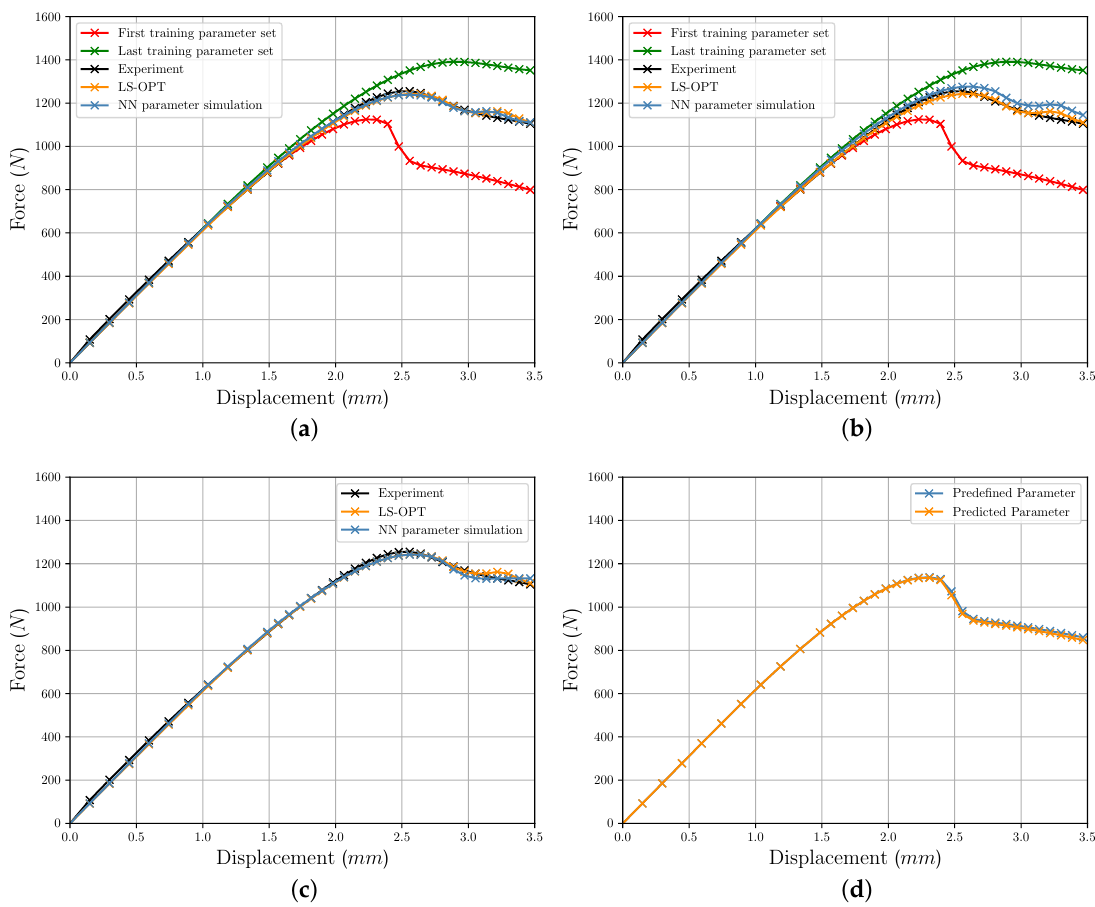
Figure 17. Comparison of calculated FDC with parameters from iterative and NN-based process for ( a ) Run_5 , ( b ) Run_10 , ( c ) Run_31 and ( d ) for one randomly chosen labeled and the corresponding predicted parameter set of Run_26